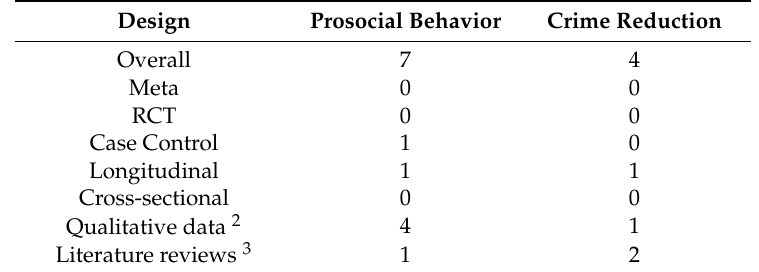
Table 8. Design of studies within impacts on crime reduction and (anti-)social behavior 1